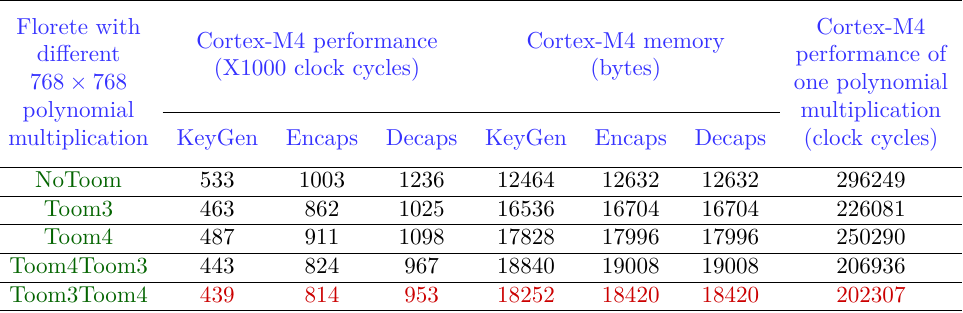
Table 10: Performance comparison in Cortex-M4 implementation of Florete with 5 different ways of 768 × 768 polynomial